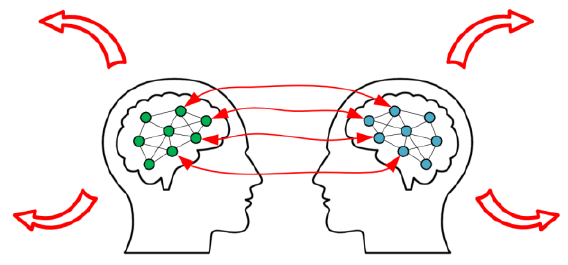
Figure 1. Illustration for the formation of a global neural network -